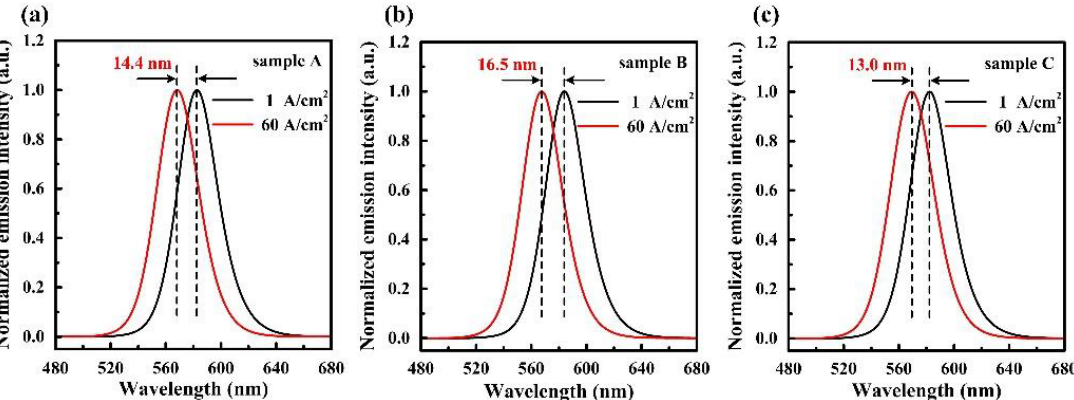
Figure 5. Normalized emission intensity of ( a ) sample A, ( b ) sample B and ( c ) sample C with increasing current density.